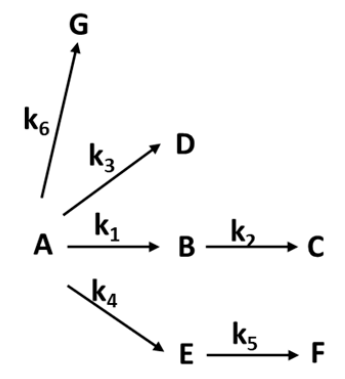
Figure 5. Scheme of proposed kinetics model of colorless PET waste degradation in SubCW. PET (A), TPA (B), benzoic acid (C), 1,4-dioxane (D), EG (E), acetaldehyde (F), IPA